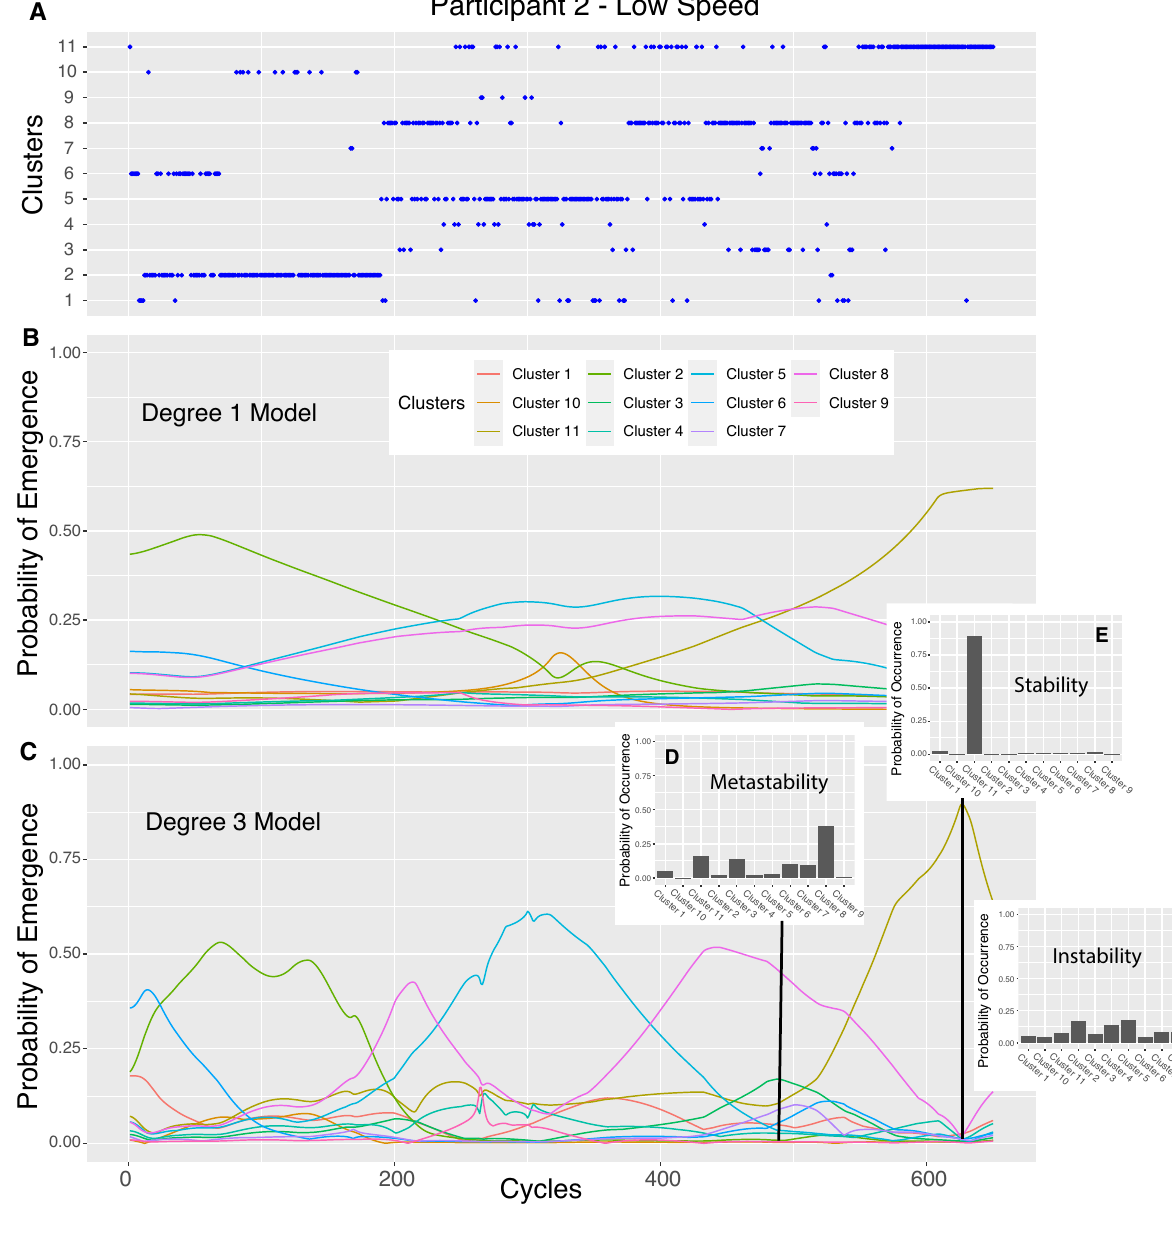
Figure 3. Individual dynamics of learning and exploration for Participant 2. ( A ) Cycle per cycle dynamics (1 dot representing one performed cycle) of coordination patterns during the entire process of learning (from cycle 1 to cycle 680). ( B ) Simulation of Drifting Markov Modelling trained on data in ( A ) showing what is the probability of appearance of each pattern during learning with a linear modelling (i.e., degree 1) of the probabilities of transition between patterns. ( C ). Simulation of Drifting Markov Modelling trained on data in ( A ) showing what is the probability of appearance of each pattern during learning with a polynomial modelling of degree 3 of the probabilities of transition between patterns. For each pattern, the quantity of exploration is computed as the distance between those two models in ( B ) and ( C ). ( D ) A section of the learning dynamics (cycle 488) showing a metastable regime with few patterns that are not really stable neither really unstable. ( E ) A section of the learning dynamics (cycle 644) showing a period of stability with one highly probable pattern. ( F ) A section of the learning process (from participant 6) showing instability with an evenly distributed probability of appearance of